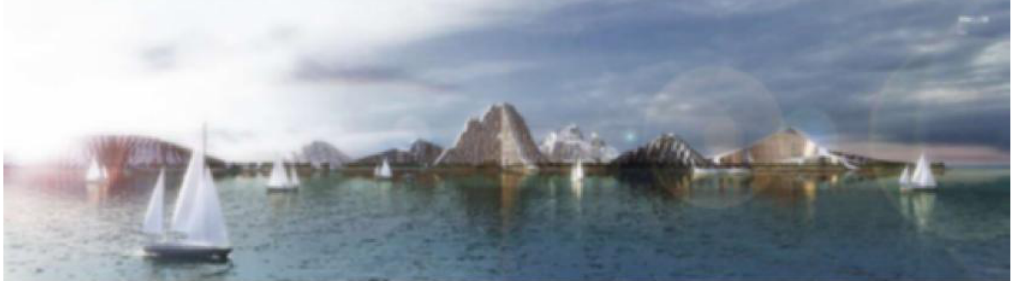
Fig. 9: A view of the Zira Island designed based on natural ecosystems (BIG,